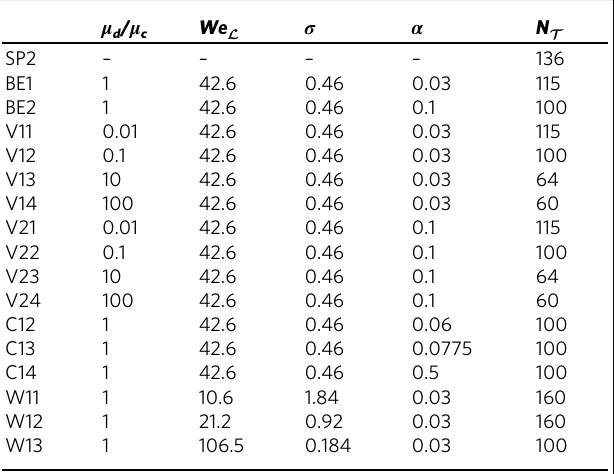
Table 1 Parameter settings for the simulations considered in this study: viscosity ratio μ d / μ c , Weber number We L with surface tension σ , volume fraction α and integration time